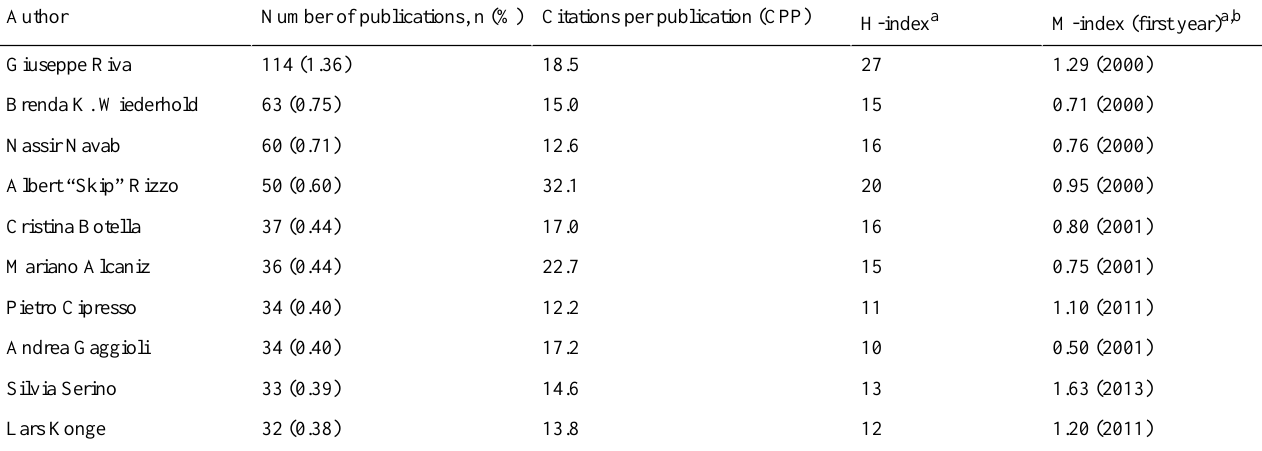
Table 1. The 10 most productive authors of virtual reality research in medicine (8399